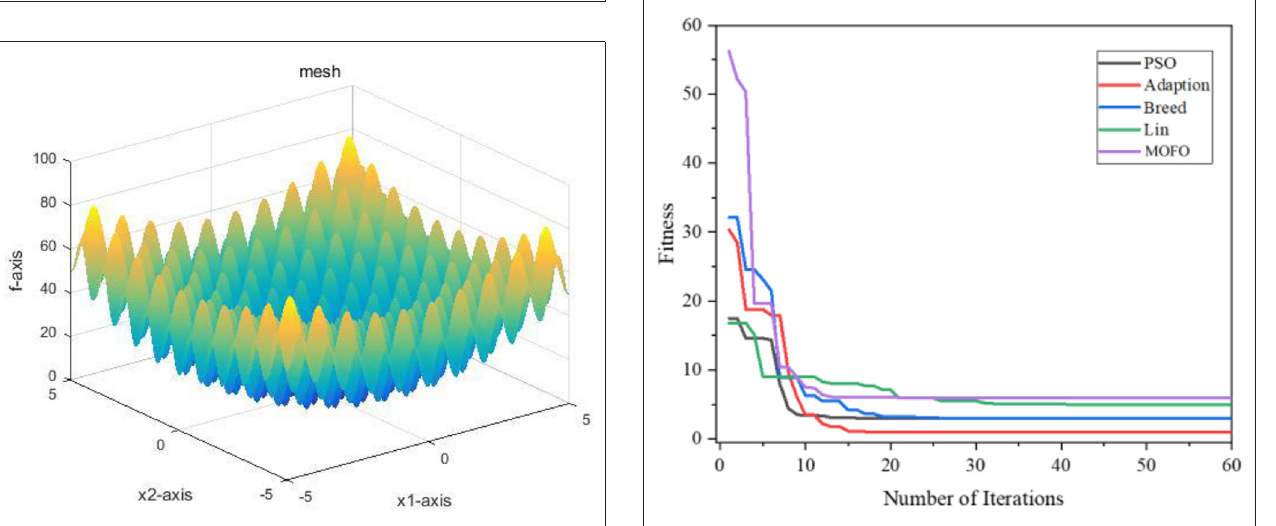
FIGURE 5 | The image of the Rastrigin function. FIGURE 6 | The Comparison of the convergence speed of different